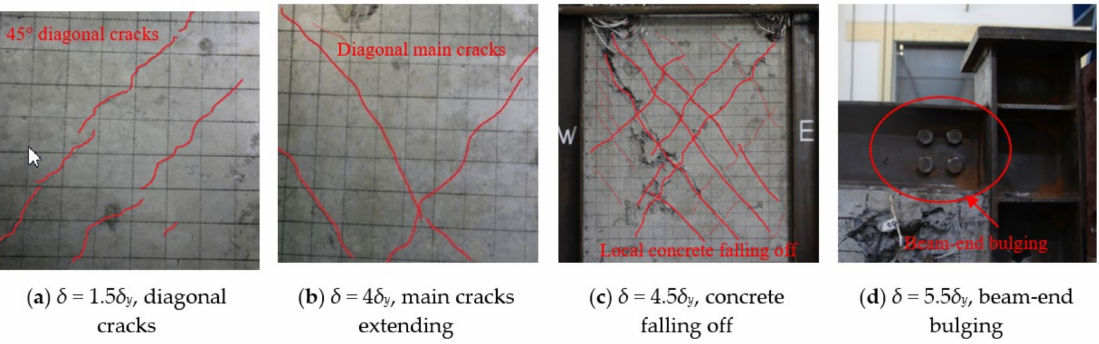
Figure 4. Local failure of